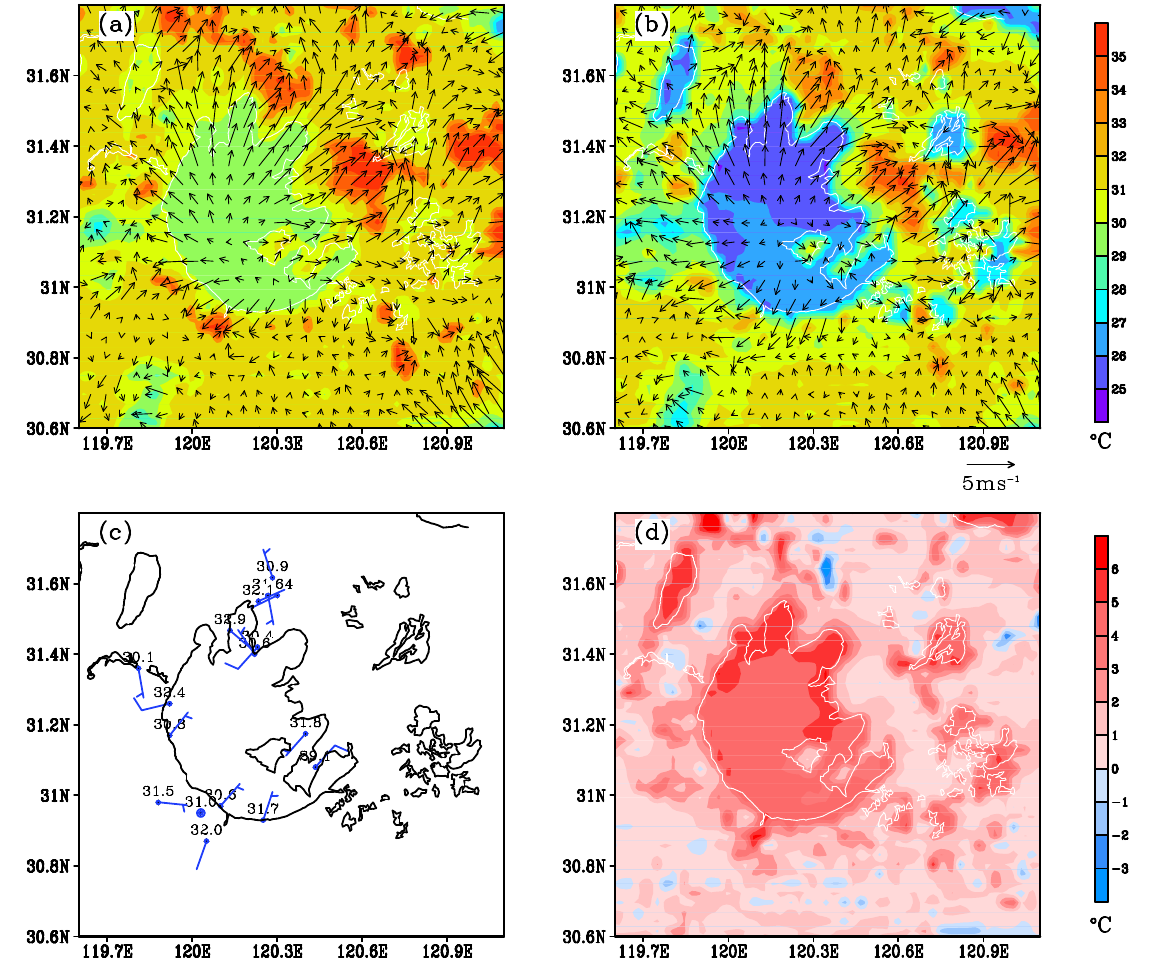
Figure 7. Modelled the wind vector, and the air temperature at 2 m at 14:00 19 July 2012 ( a ) by S-Lake; ( b ) by D-Lake; ( c ) observed by meteorology station; ( c ) Observation by sites. The long pole is 4 m s −1 , and the short pole is 2 m s −1 ; ( d ) difference between S-Lake and D-Lake.